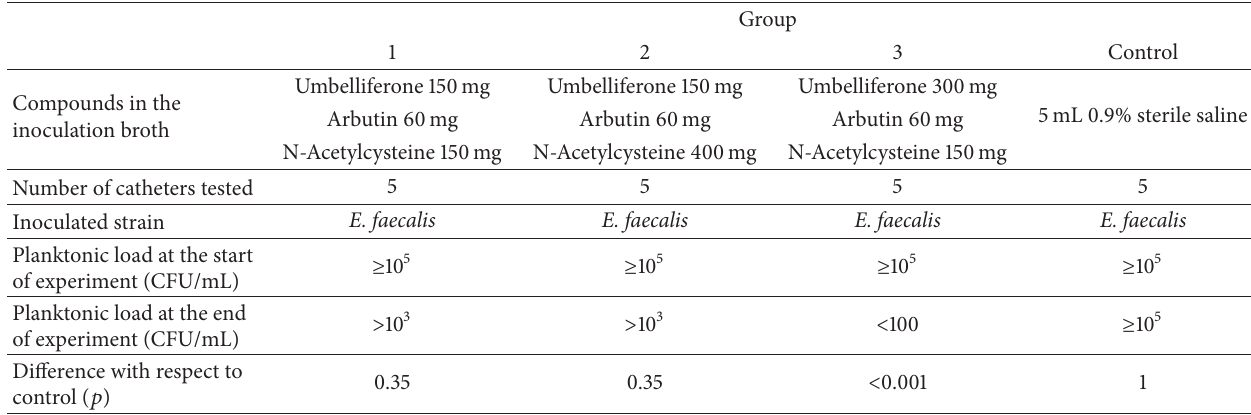
Table 1: Group characteristics and results of the quantification of planktonic load in the incubation medium at the beginning and at the end of the experiment.